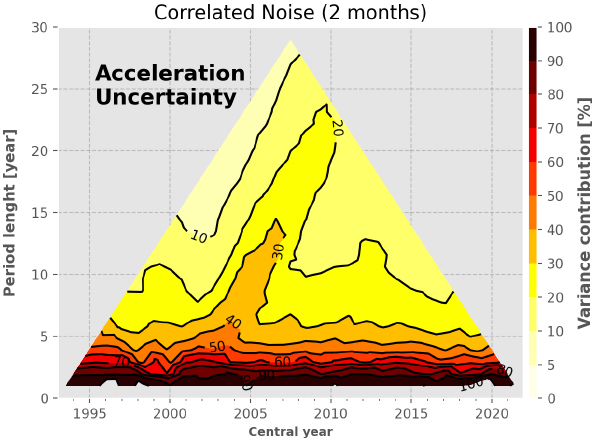
Figure B4. Variance contribution to the GMSL acceleration vari- ance of the orbit solutions.